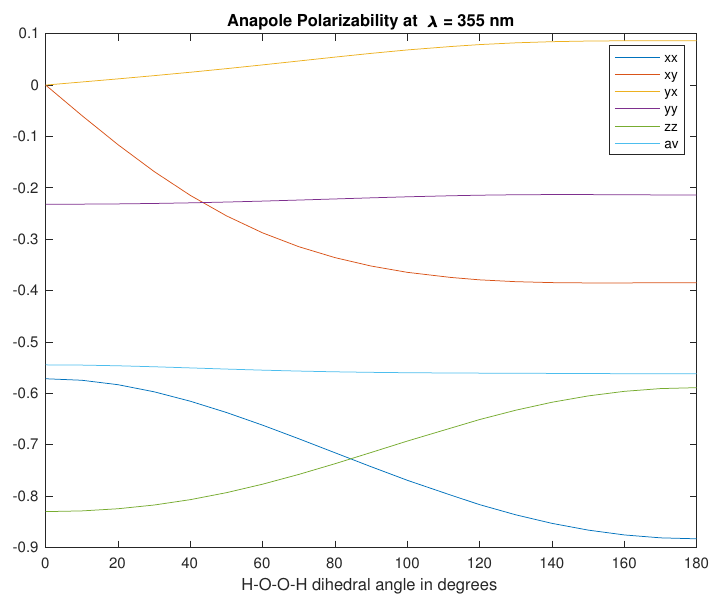
Figure 2. Tensor components of anapole polarizability f (cid:48) peroxide molecule computed at the TD-HF level by Equation (16) for λ = 355 nm, as a function of the dihedral